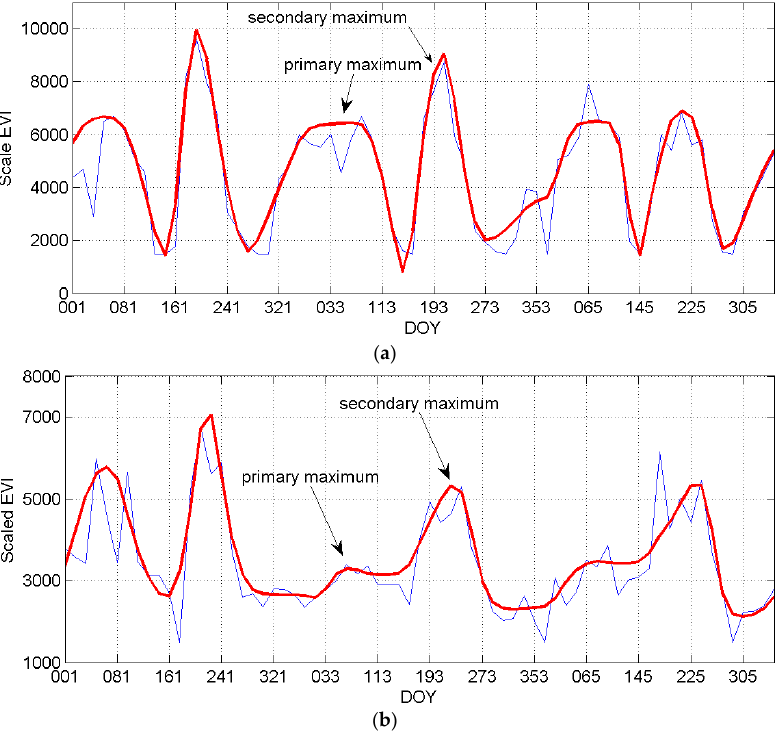
Figure 2. Profiles of time-series (EVI) data, ( a ) for two annual seasons and ( b ) for one annual season. DOY, the day of a